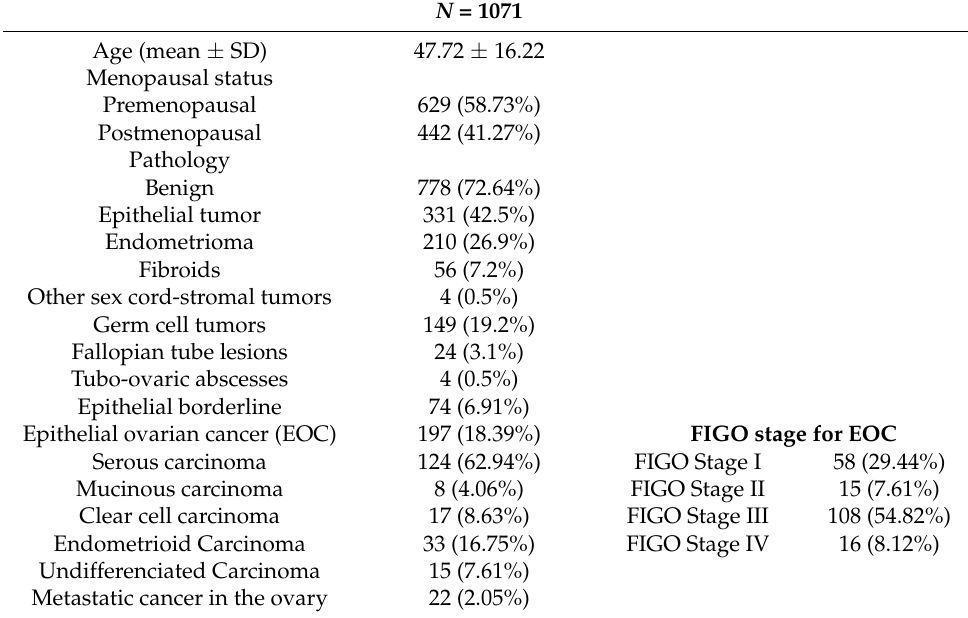
Table 1. General characteristics of the study